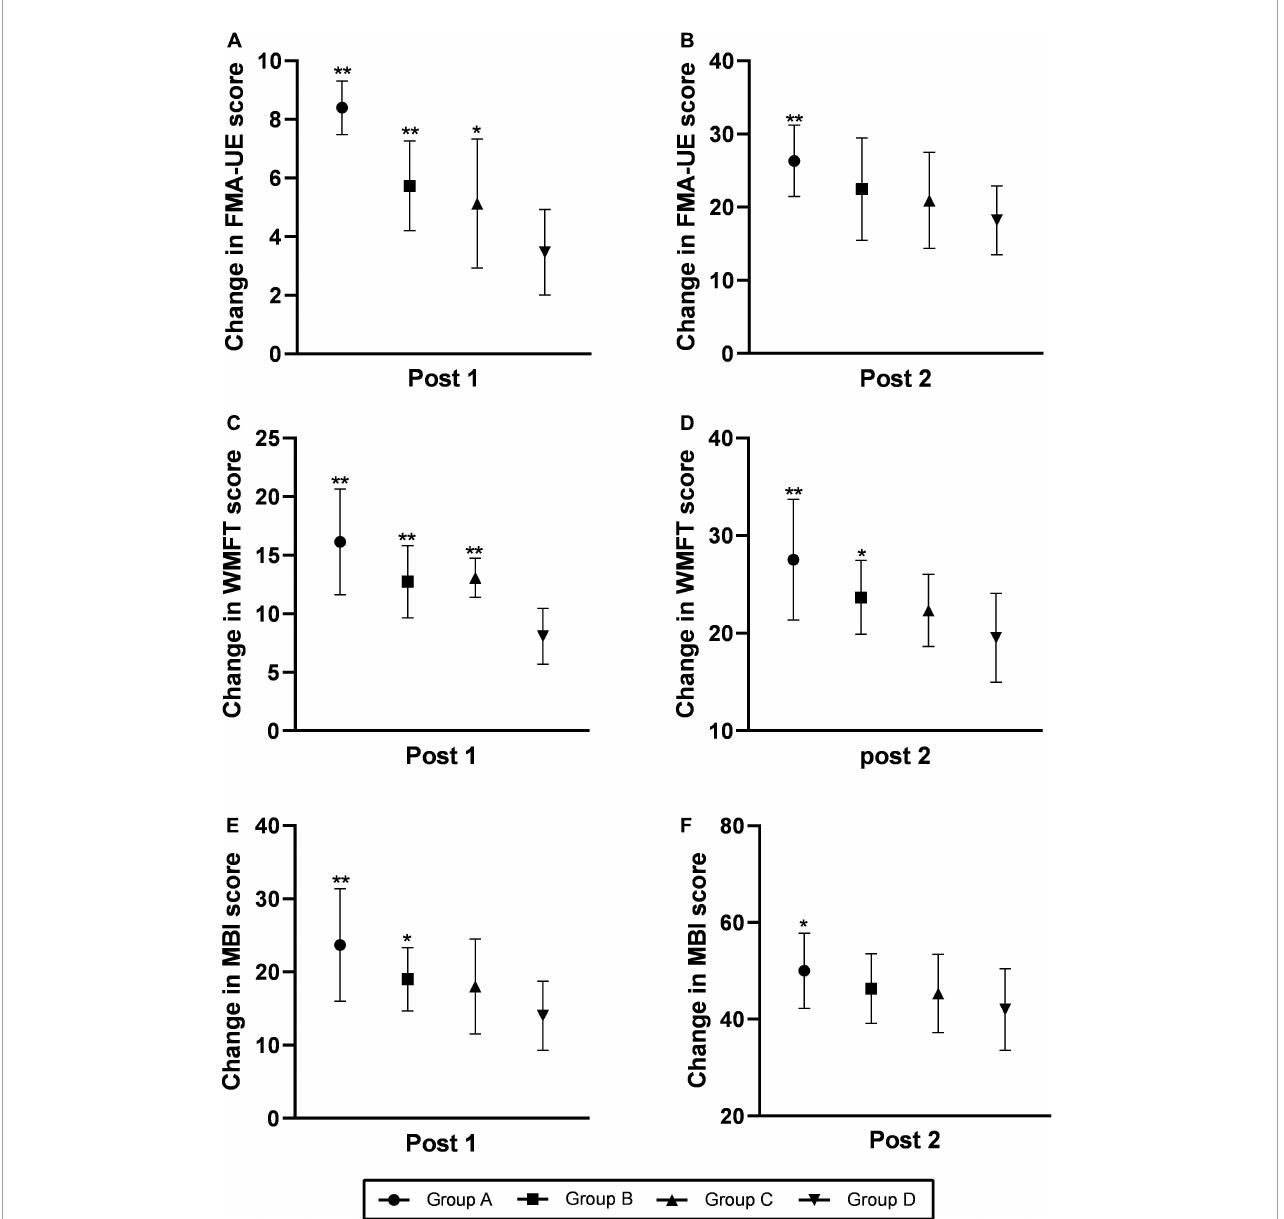
FIGURE3 Comparison of changes in the FMA-UE (A,B) , WMFT (C,D) , and MBI (E,F) scores at the time of post-treatment (post 1) and the 3-month follow-up (post 2). Changes were calculated as follows: post-intervention value minus baseline value. The data were shown as the mean ± standard deviation values. Comparisons of value changes among the four groups were performed using ANOVA. * p < 0.05 and ** p < 0.01 relative to group D. FMA-UE, Fugl-Meyer Assessment of the Upper Extremity; WMFT, Wolf Motor Function Test; MBI, Modified Barthel